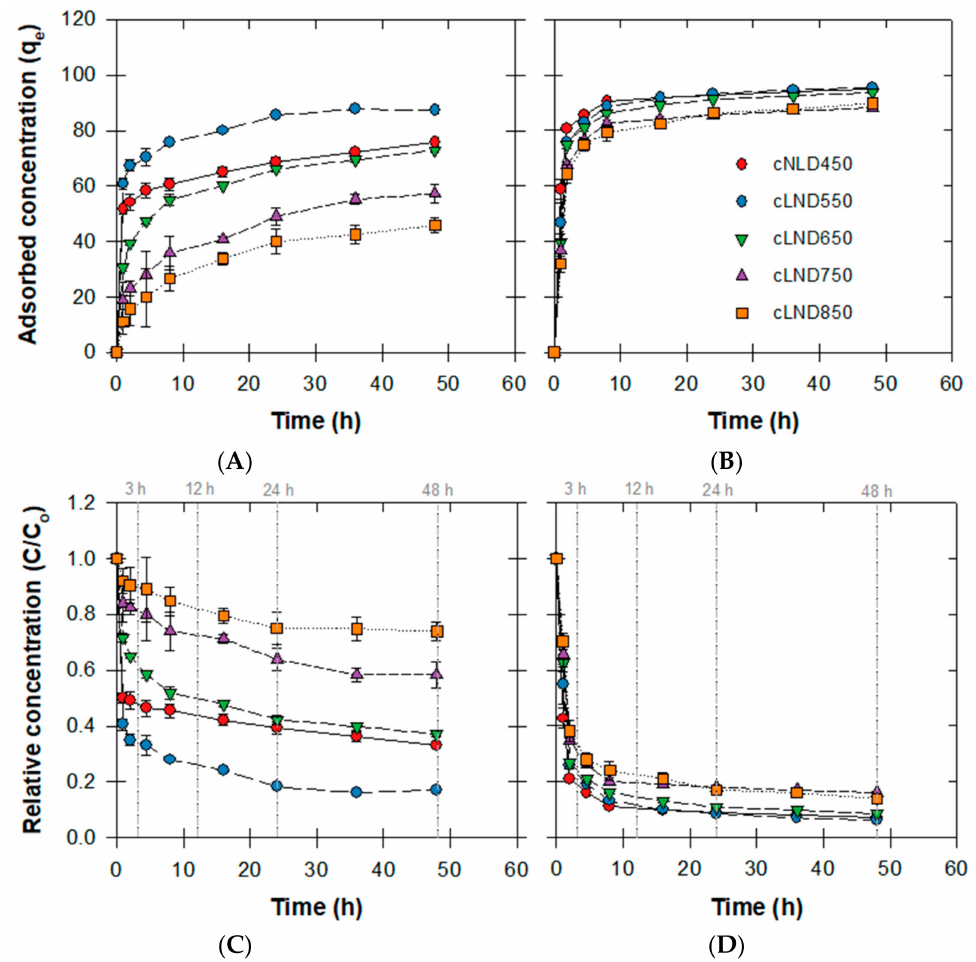
Figure 3. Adsorption kinetic studies of varying cLND with SMX or ENR. ( A , B ) Temporal changes in the antibiotic concentrations. ( C , D ) Temporal changes in the adsorbed concentrations in